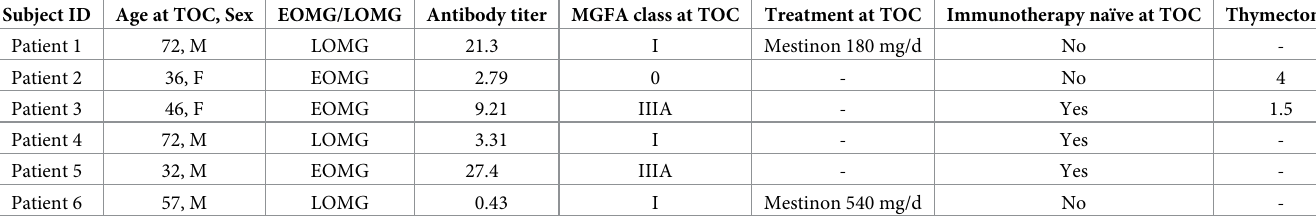
Table 2. Characteristics of six AChR MG patients with reduced complement activity.